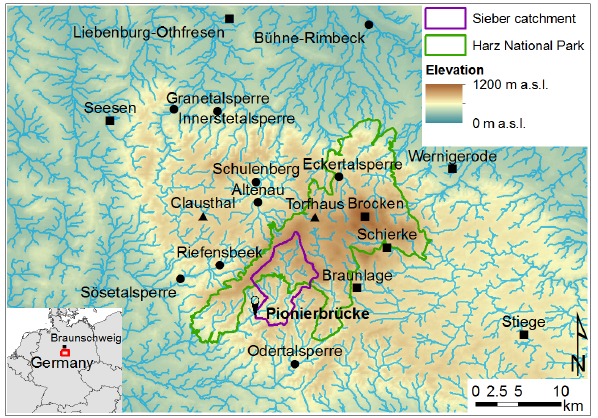
Figure 1. Map of the study area including the Sieber catch- ment (watershed boundary is magenta colored) located in the Harz Mountains, northern Germany. The station network shown on the map provides hourly time series for precipitation only (cir- cles), precipitation and temperature (triangles), and additional ob- servations (squares). The Harz National Park boundary is pro- vided by OpenStreetMap, © OpenStreetMap contributors (http://